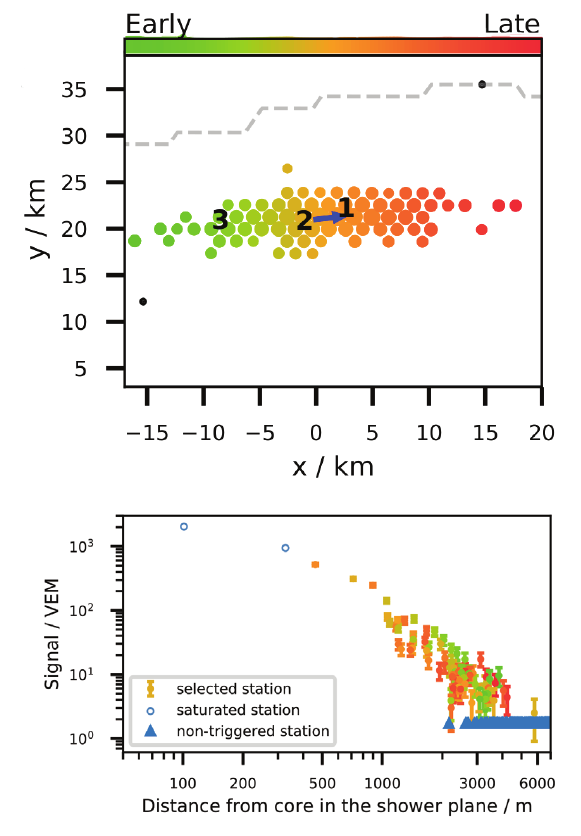
Figure 3. Top : Footprint on the ground of the most-energetic inclined shower detected at the Pierre Auger Observatory, PAO150926 (#17). Bottom : The distribution of the recorded sig- nals as a function of the distance of the same event.